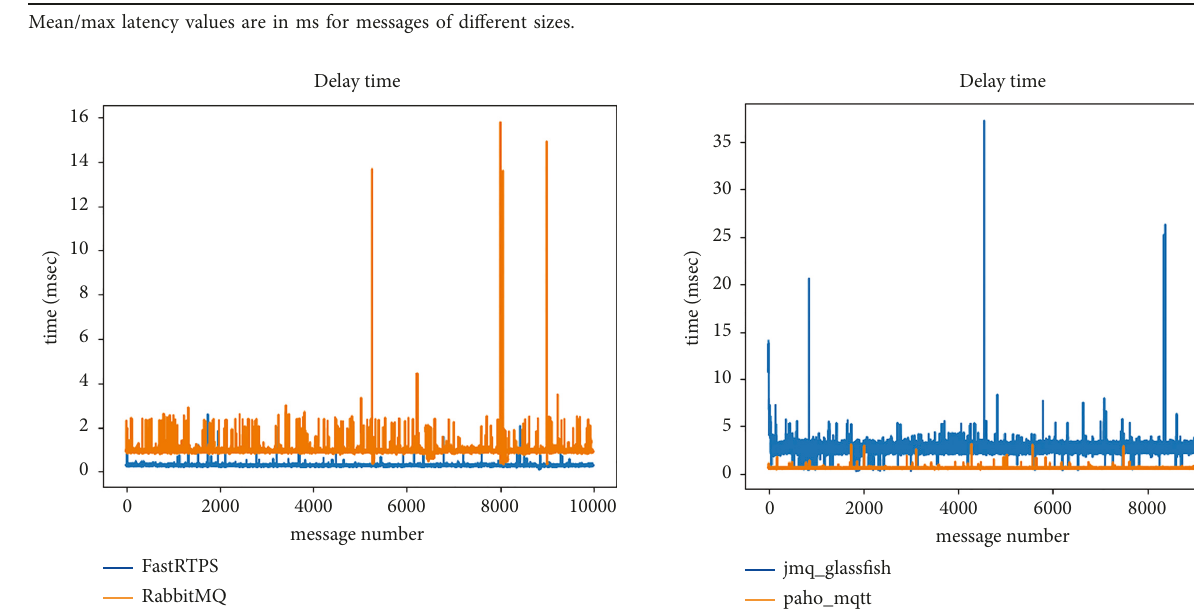
Figure 11: GlassFish’s and Paho+Mosquitto MQTT’s delay of minimum message size.